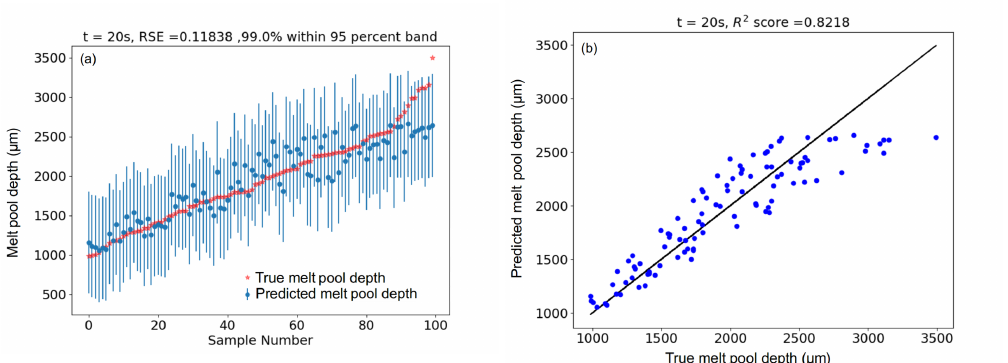
Figure 9. Melt pool depth and width prediction performance at 2 s with a training set size of 20 samples. ( a , b ) Probabilistic prediction of depth and corresponding parity plot. ( c , d ) Probabilistic prediction of width and corresponding parity plot. Samples arranged in ascending order of the true values in panels ( a , c ). Predicted values at the points of query are represented as follows; GP mean by blue dots and ± 2 σ bands by vertical bars, where σ is the standard deviation of the GP’s posterior prediction at a query point. Red stars indicate the true value of the melt pool depth at those